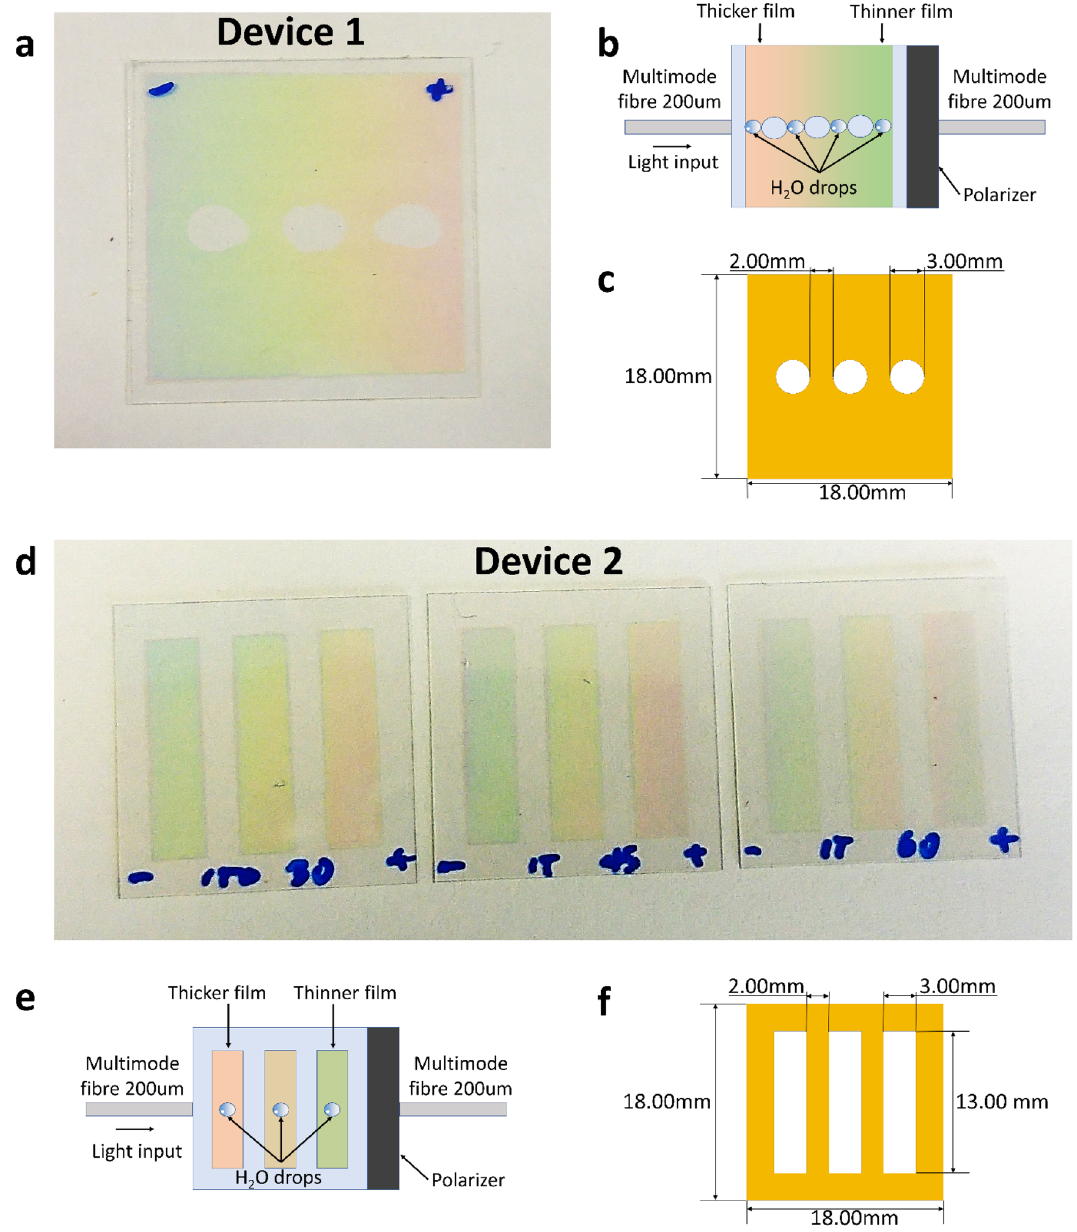
Figure 2. Samples deposited with and without a mask. (a) Device 1: experimental sample deposited with a gradient in thickness and segmented with HCl etching in different regions. (b) Details and dimensions of the mask used when removing the coating of the sample shown in (a) using HCl. (c) Schematic of the experiment on the sample shown in this figure: water drops were placed on top of each region deposited with different thickness. (d) Device 2: experimental sample deposited with a mask with platform of slope 30, 45, and 60, respectively. (e) Schematic of the experiment with water drops placed on top of the strips or electrodes in (d) . (f) Dimensions of the mask used for generating the strips or electrodes in (d)